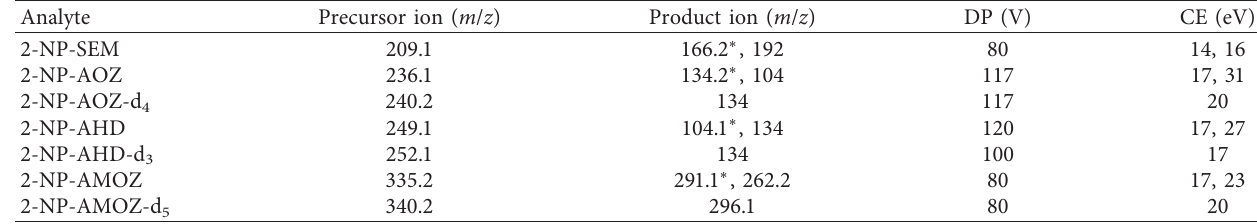
Table 1: Mass spectrometry parameters for the analysis of 2-NP-NFMs and their ISs.